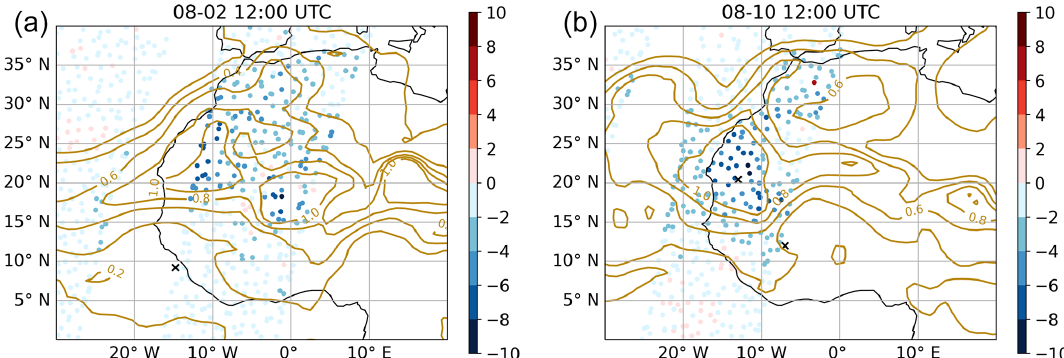
Figure 9. AER–CTL differences in simulated BT at 12.93µm from the IASI (colored circles) with the NGAC AOD (brown contours) on 2 August, 12:00UTC (a) , and 10 August, 12:00UTC (b) . The crosses (X) mark the location of the wave centers for the AEW that developed Gert ( a ; 8 ◦ N, 14 ◦ W) and Harvey ( b ; 12 ◦ N, 17 ◦ W and 20.5 ◦ N, 13 ◦ W). Color bar units are in kelvin